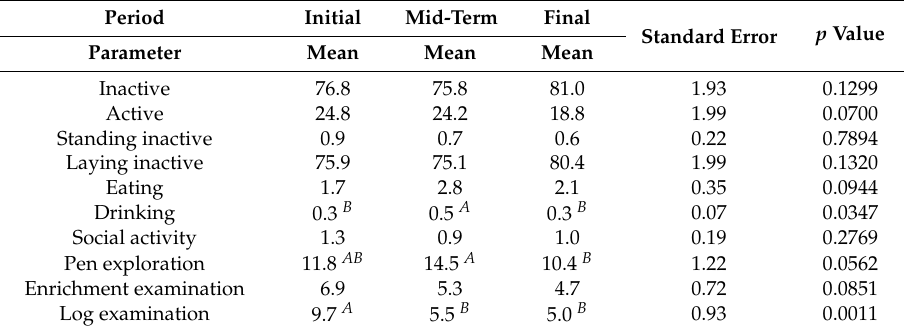
Table 5. Behavioural observations by period (%).